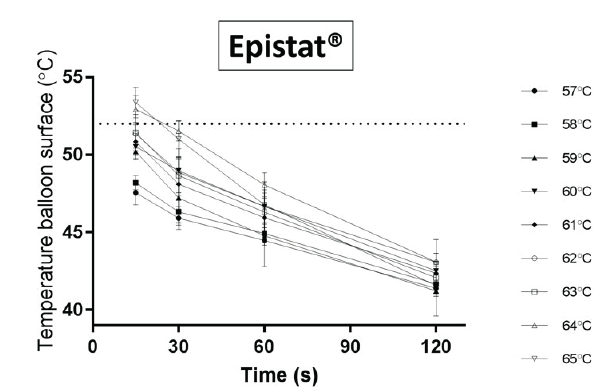
Figure 2. Balloon surface temperature as a function of time after hot water insertion (mean ± SD). The different symbols indicate the different water temperatures at baseline. Please note how there is a rapid decline in balloon surface temperature. The dotted line indicates maximum sur- face temperature of 52 0C , which has been shown to be the threshold for necrosis of nasal mucosa.